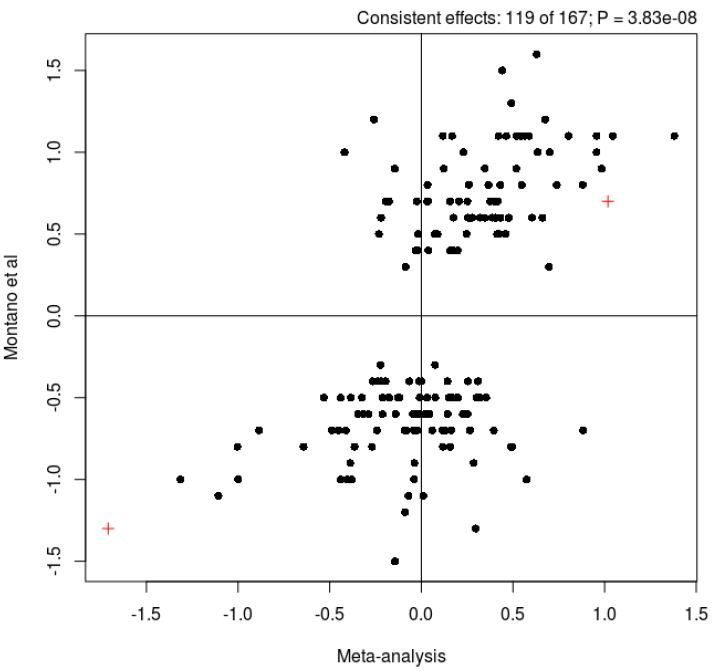
Comparison of results from our EWAS meta-analysis with those for 167 replicated SZ-associated DMPs identified by Montano et al.Overall there is a significant enrichment of consistent results between the analyses for these DMPs. The red crosses highlight the two DNAm sites that were reported as significant by Montano et al. and also passed our multiple testing threshold in our meta-analysis.